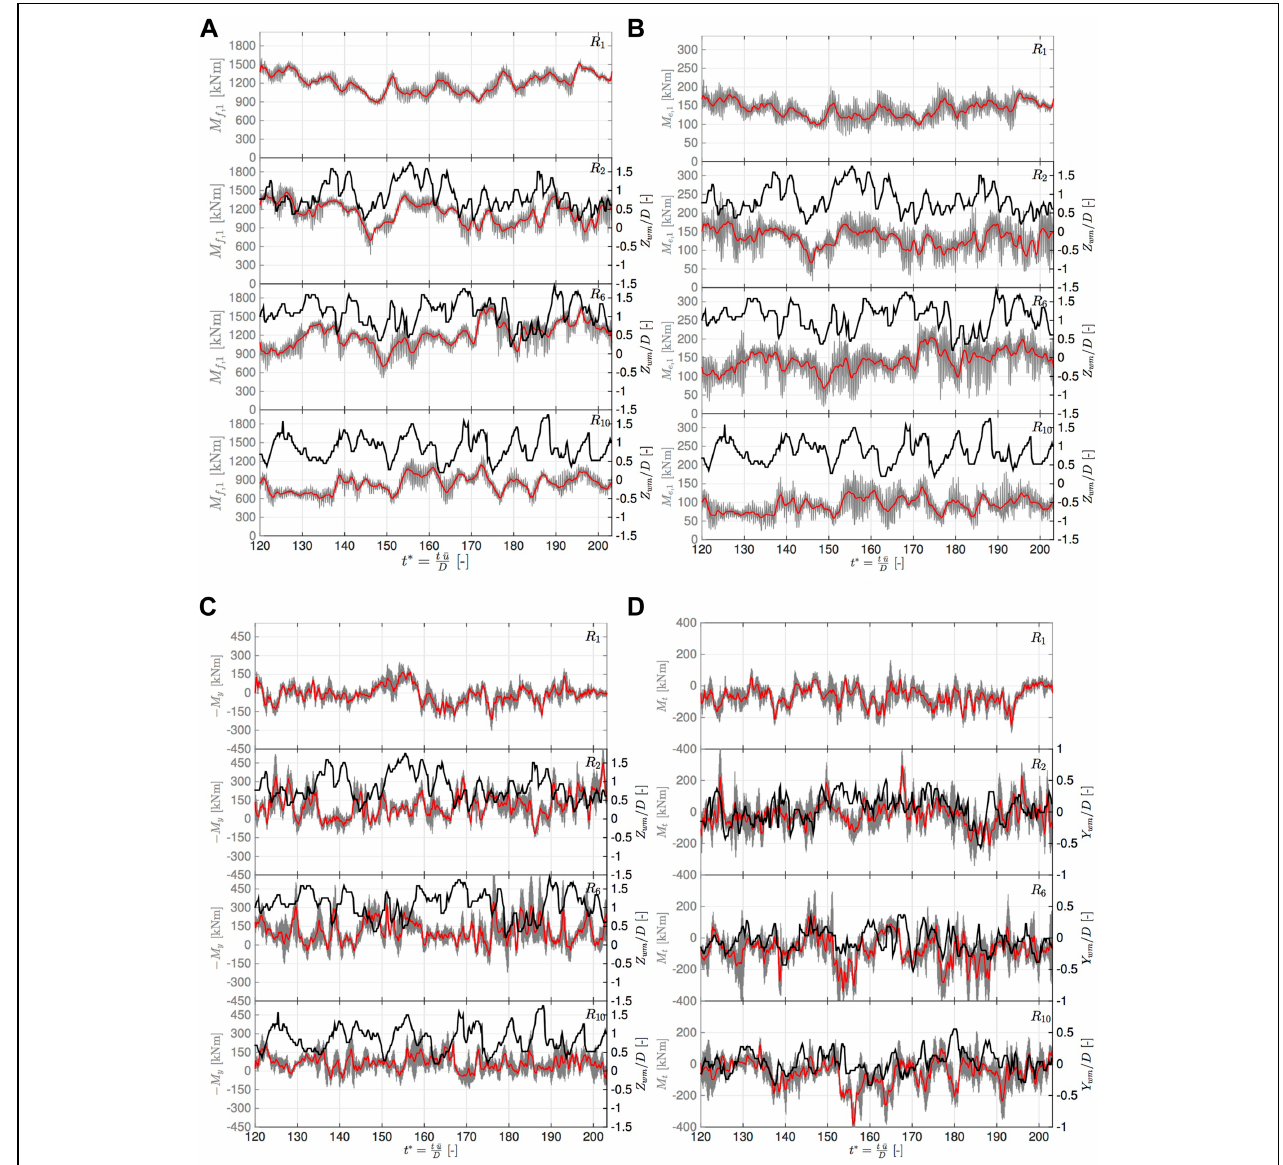
FIGURE 7 | Histories of the flapwise (A) and edgewise (B) root bending moments and of the yaw (C) and tilt (D) moments for α w = 262 ° and rows R 1 , R 2 , R 6 and R 10 (grey lines). The filtered signals of M f , 1 and M e , 1 at f Ω , and of M y and M t at 3 f Ω are also added (red lines). The wake centerline position just upstream of the machine is also reported for rows R 2 , R 6 and R 10 (black